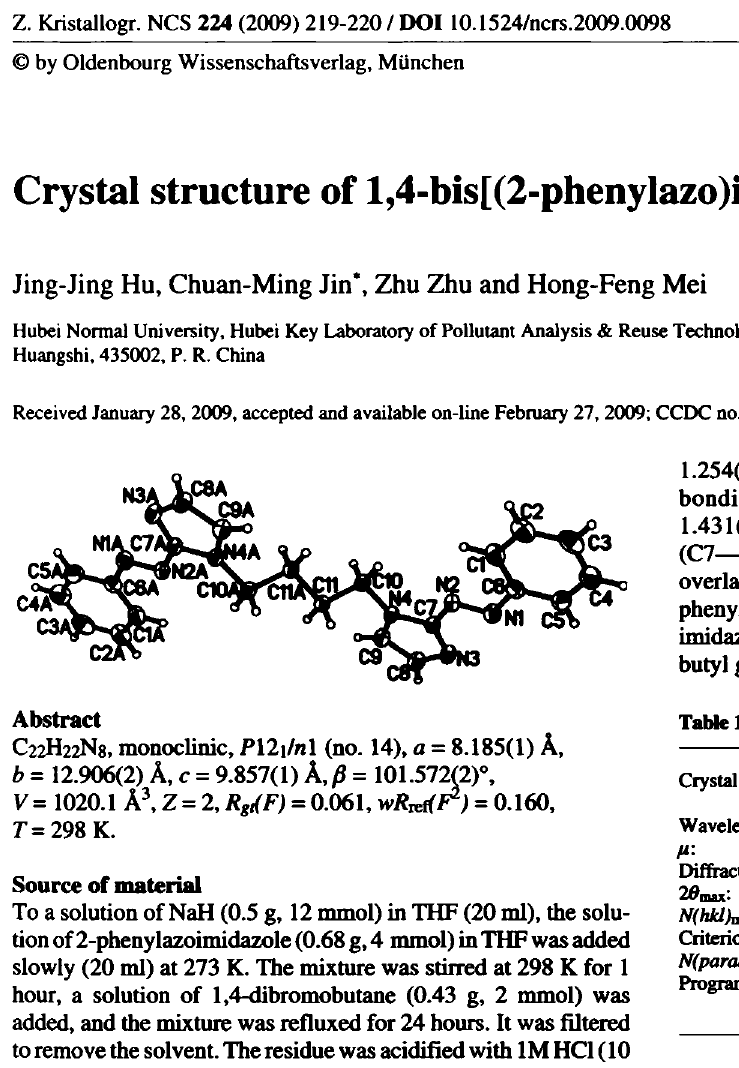
Table 2. Atomic coordinates and displacement parameters (in Â 2 ).